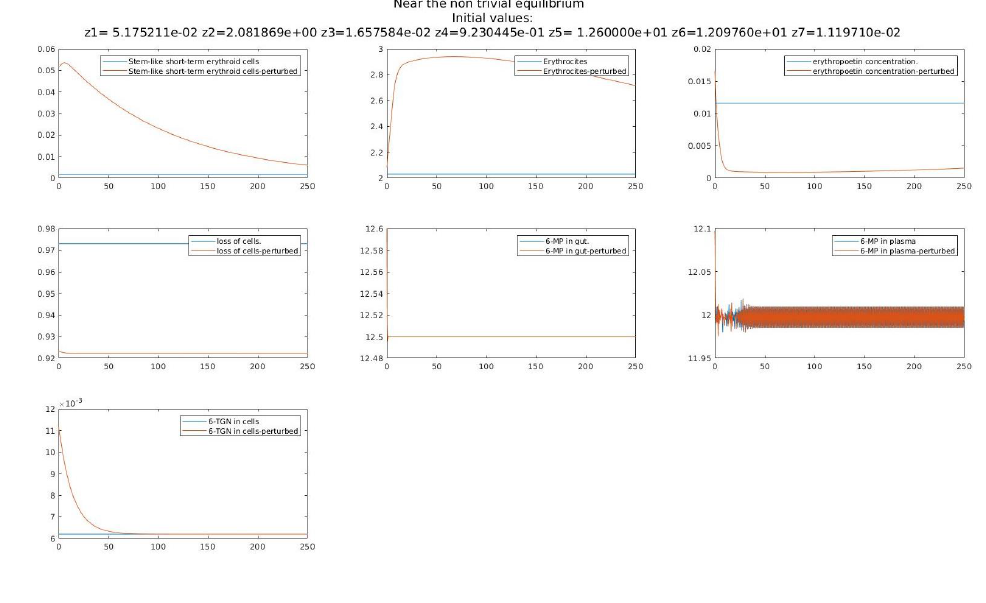
Figure 2. Stability of equilibrium point E 2